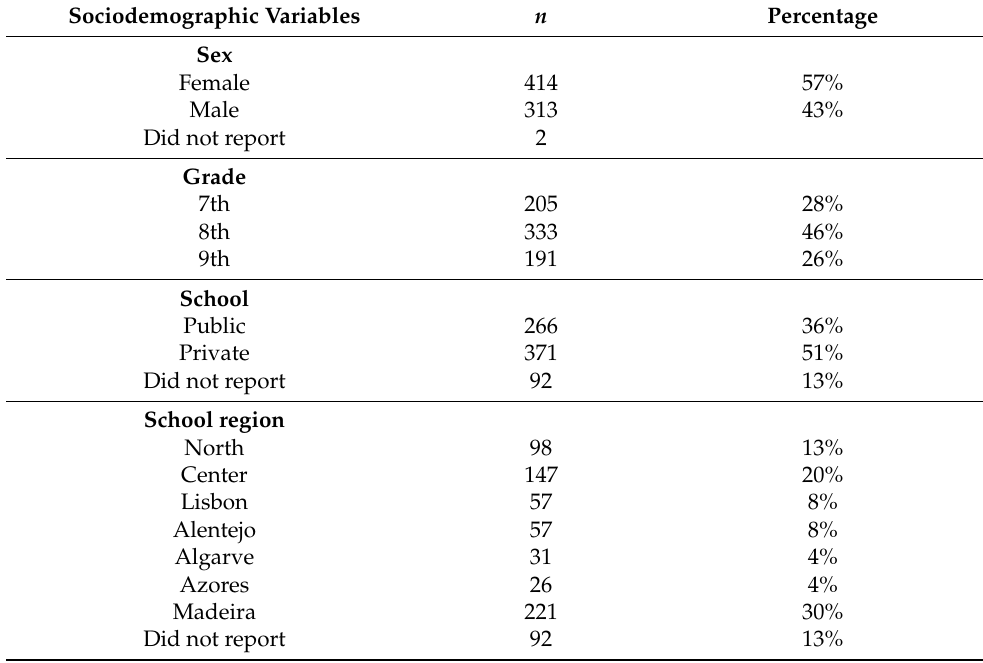
Table 1. Youths’ sociodemographic